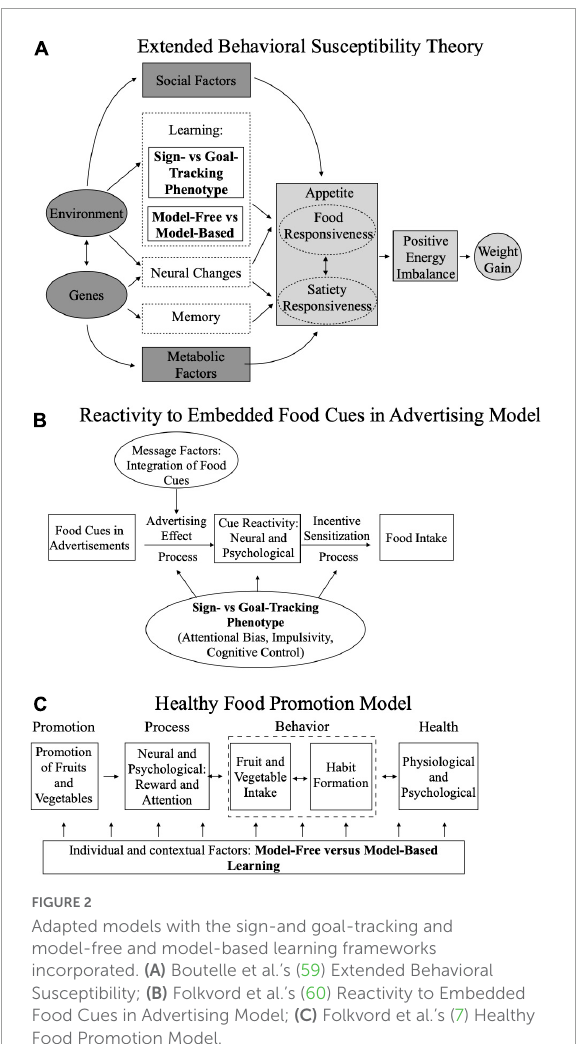
FIGURE2 Adapted models with the sign-and goal-tracking and model-free and model-based learning frameworks incorporated. (A) Boutelle et al.’s (59) Extended Behavioral Susceptibility; (B) Folkvord et al.’s (60) Reactivity to Embedded Food Cues in Advertising Model; (C) Folkvord et al.’s (7) Healthy Food Promotion